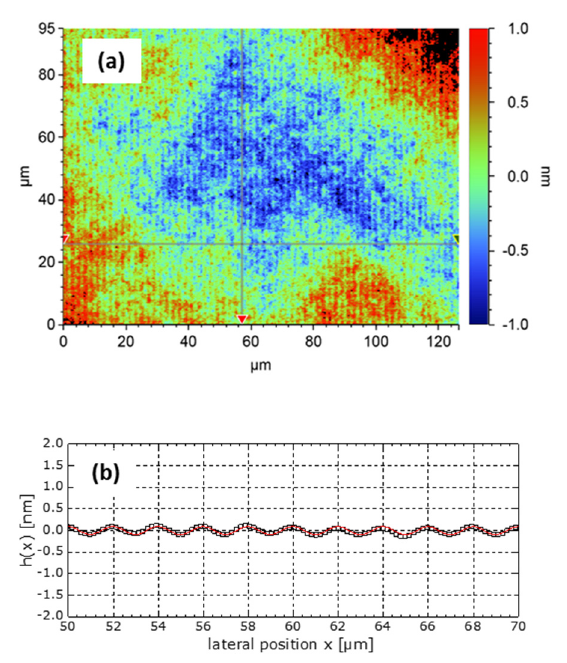
Fig. 3. WLI (50 x objective) measurements of Au coated surface profiles with 2 µm period: (a) measured surface topography, (b) averaged profile (open symbols), and sinusoidal fit to the measured profile (red